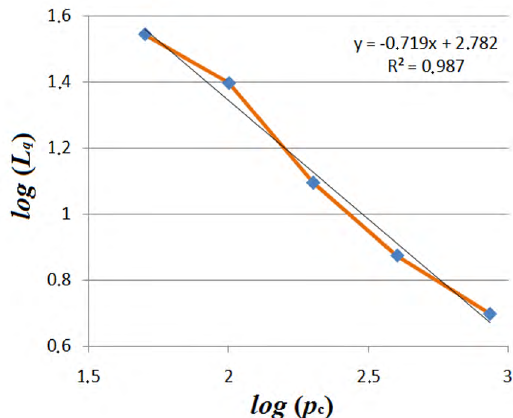
) vs log ( p ) for CB. q c of 860 occupied q